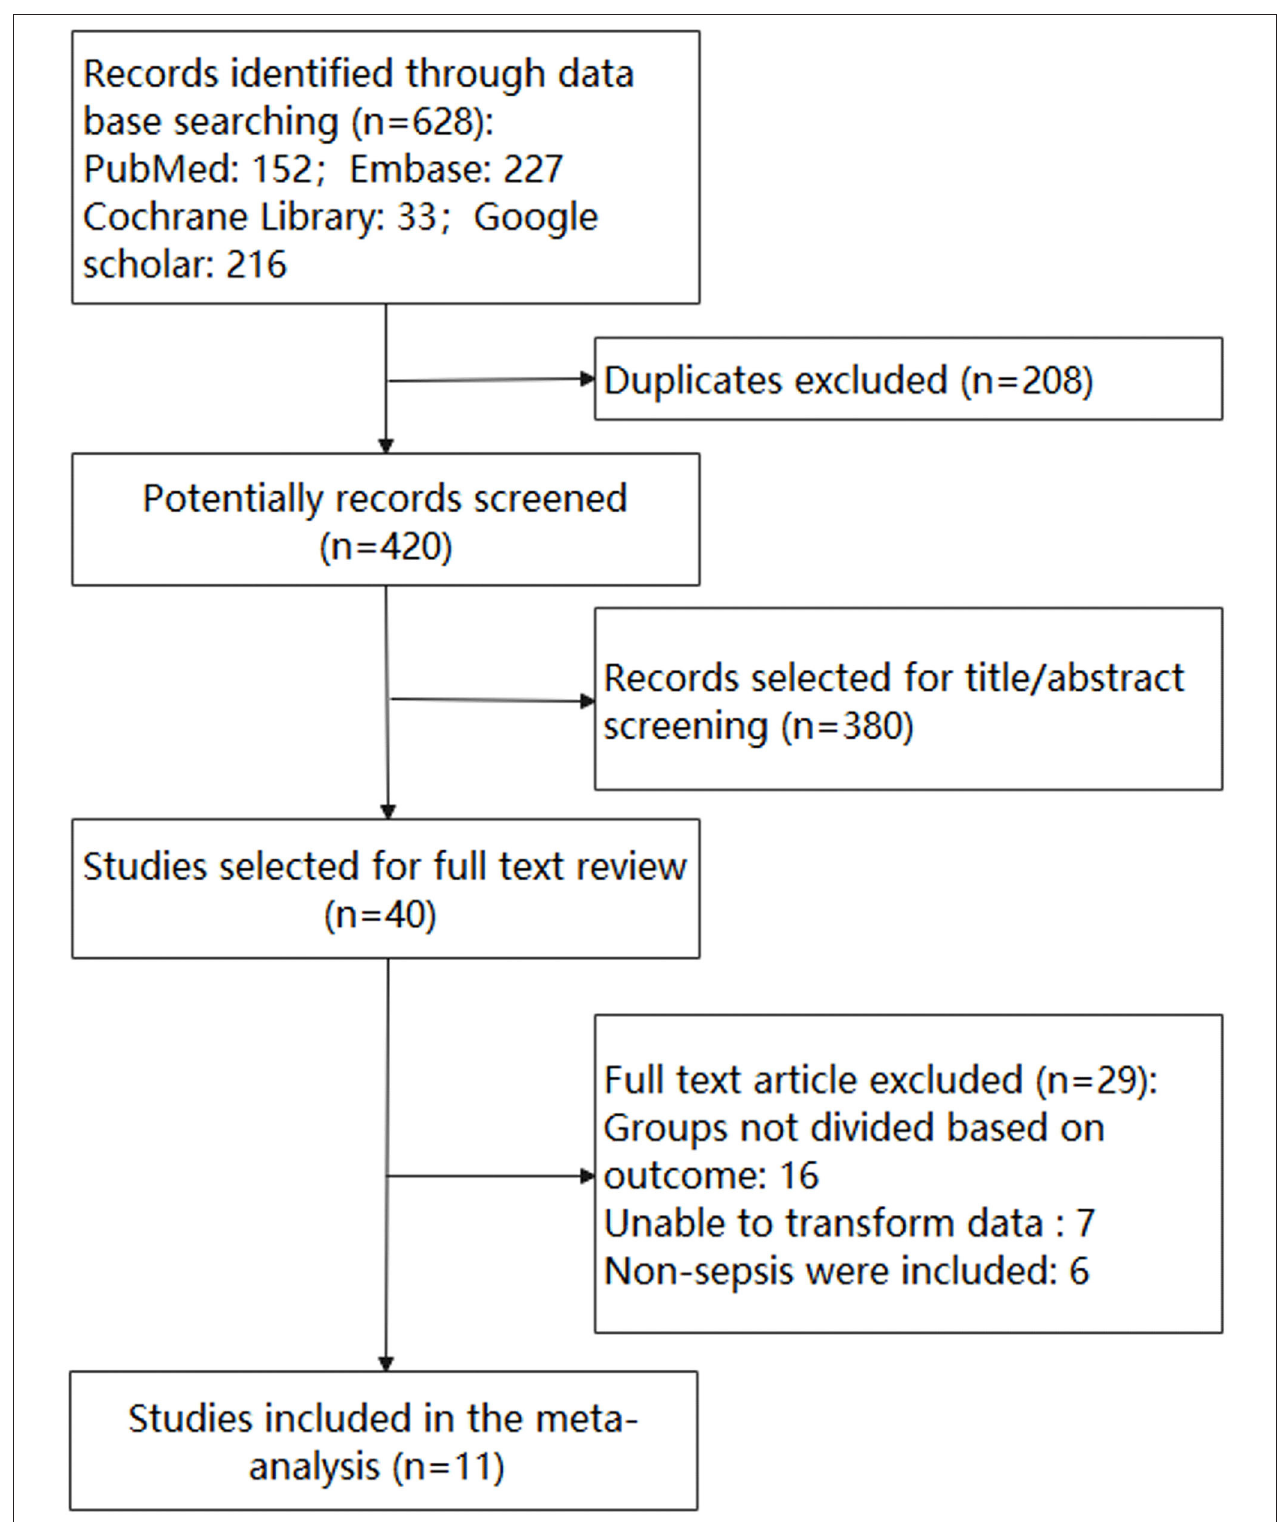
FIGURE 1 | Flow diagram for the identification of eligible